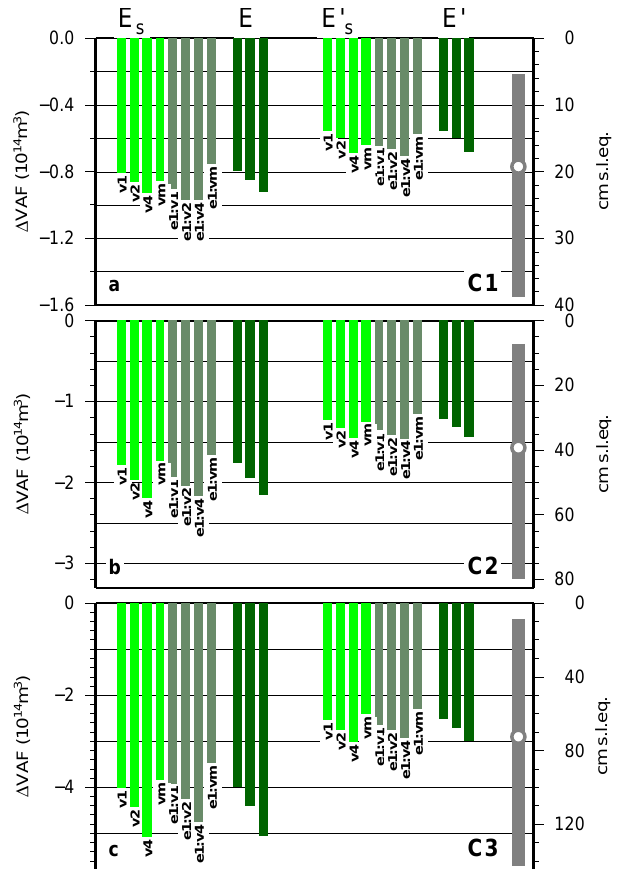
Figure 6. The same figures as Fig. 2 under experimental config- uration of E s , E , E (cid:48) s , E (cid:48) . The group on the left-hand side applies Tarasov and Peltier (2002) while the right-hand side applies Huy- brechts and de Wolde (1999) for the surface mass balance compu- tation. The configurations E s and E (cid:48) s contain eight different combi- nations of the basal-sliding coefficients ( v1 , v2 , v4 , and vm ) and the ice enhancement factor ( E = 3 as default and E = 1 indicated as e1